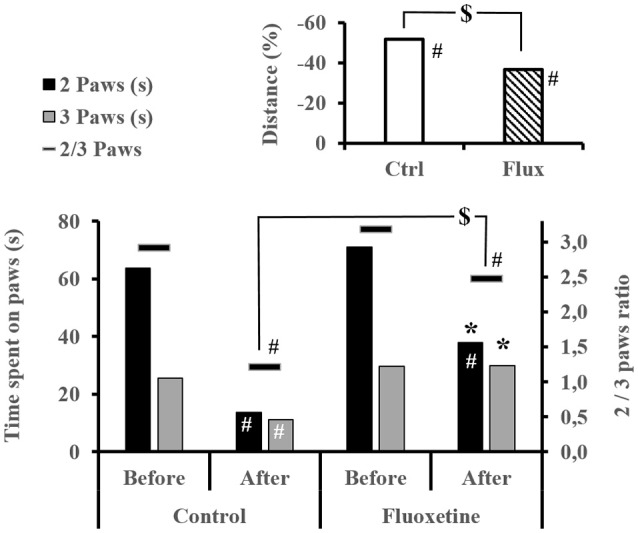
Exploratory behavior by video tracking. Time spent on 2 or 3 paws and its ratio, and the mean distance walk in each group, within the video box for 4 min. #Intragroup significant difference (p < 0.05) between before and after the dive. *Significant difference (p < 0.05) between groups after the dive for the evolution of the same parameter. $Trend (p < 0.01) at the intergroup level.